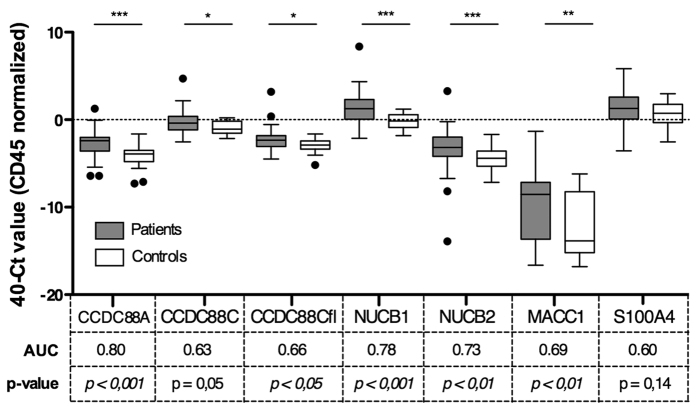
mRNA expression levels for selected genes in CTCs enriched from the peripheral blood of patients with metastatic colorectal cancer (mCRC) and healthy controls.CTC-enriched samples from the peripheral blood of 51 patients with mCRC and from 24 healthy volunteers were analyzed for mRNA levels for selected genes. Box plots show relative Ct values for mRNA from patients (gray boxes) and healthy controls (white boxes). The y axis is the qPCR Ct value for each gene, subtracted from 40 (max Ct value possible), and normalized to CD45 Ct count. CD45 is a commonly used marker of non-specific contamination with human peripheral blood lymphocytes30; CD45 level did not differ significantly between patients and controls. Area under the ROC curve (AUC) is presented below each marker, along with the p values (see Methods). *p < 0,05; **p < 0,01; ***p < 0,001.